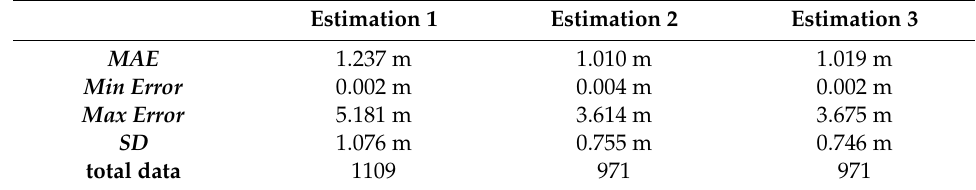
Table 4. Error Calculation of the di ff erent elevation between the real mineral soil line and the estimation